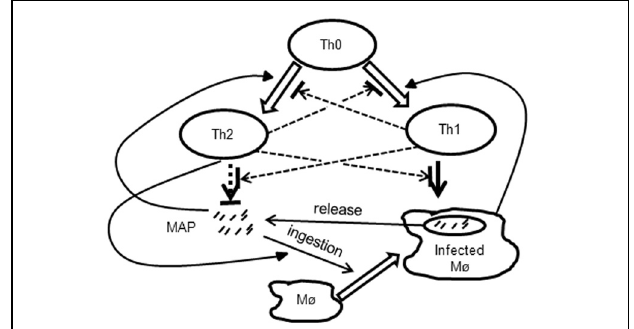
FIGURE 3 | Schematic representation of interactions between the bacteria and MAP-specific immune responses occurring JD. During the infection, resting macrophages internalize extracellular MAP bacteria. Resting macrophages are unable to clear the bacteria, and after several rounds of replication macrophages rupture releasing more extracellular bacteria. Naïve CD4 + (Th0) cells differentiate either into Th1 or Th2 subsets depending on the density of infected macrophages or extracellular bacteria, respectively. Th1 and Th2 responses interact by inhibiting differentiation of naïve T cells and by reducing effector function of the opposite subset. Th1 response activates resting macrophages which are then able to clear the bacteria. Th2 response may contribute to the pathogenesis of the JD by increasing the uptake of extracellular bacteria by